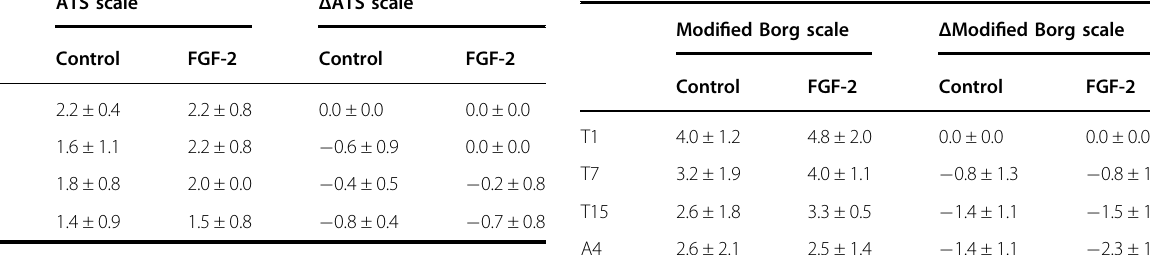
Table 4 Modi fi ed Borg scale and Δ Modi fi ed Borg scale of each group during and after FGF-2 treatment in a clinical